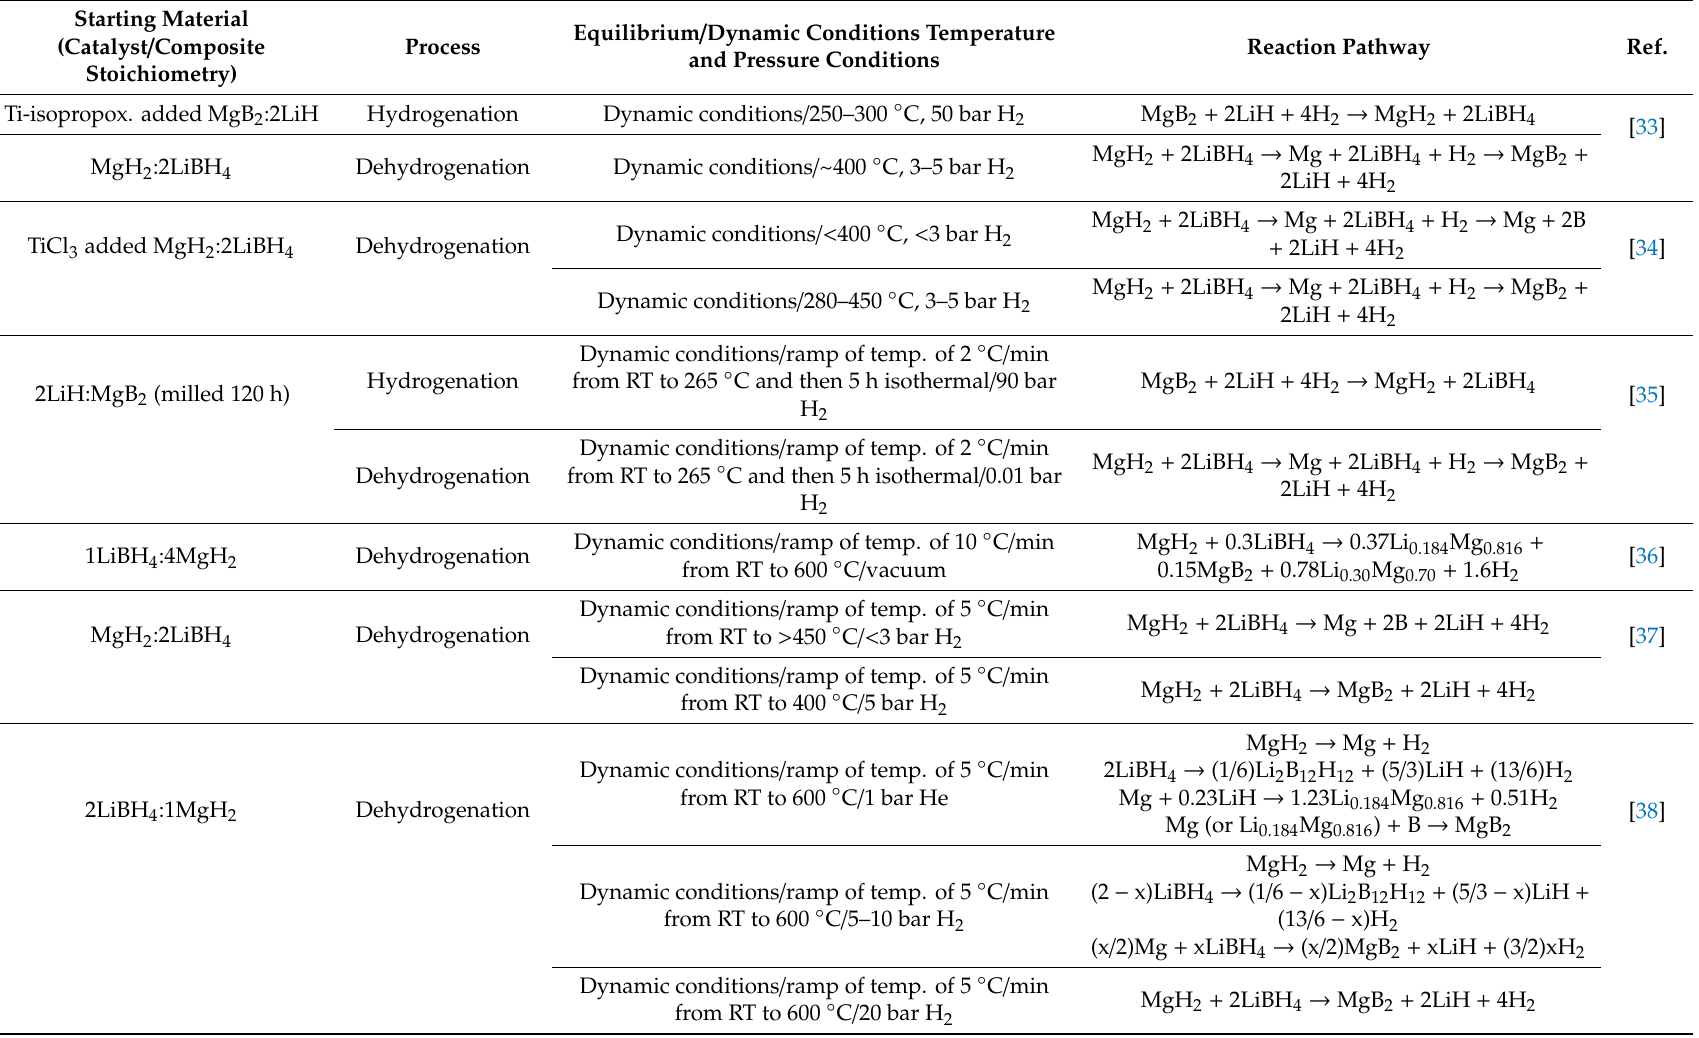
Table 1. Reaction pathways for the 2LiBH 4 − MgH 2 system: hydrogenation and dehydrogenation processes under dynamic or equilibrium